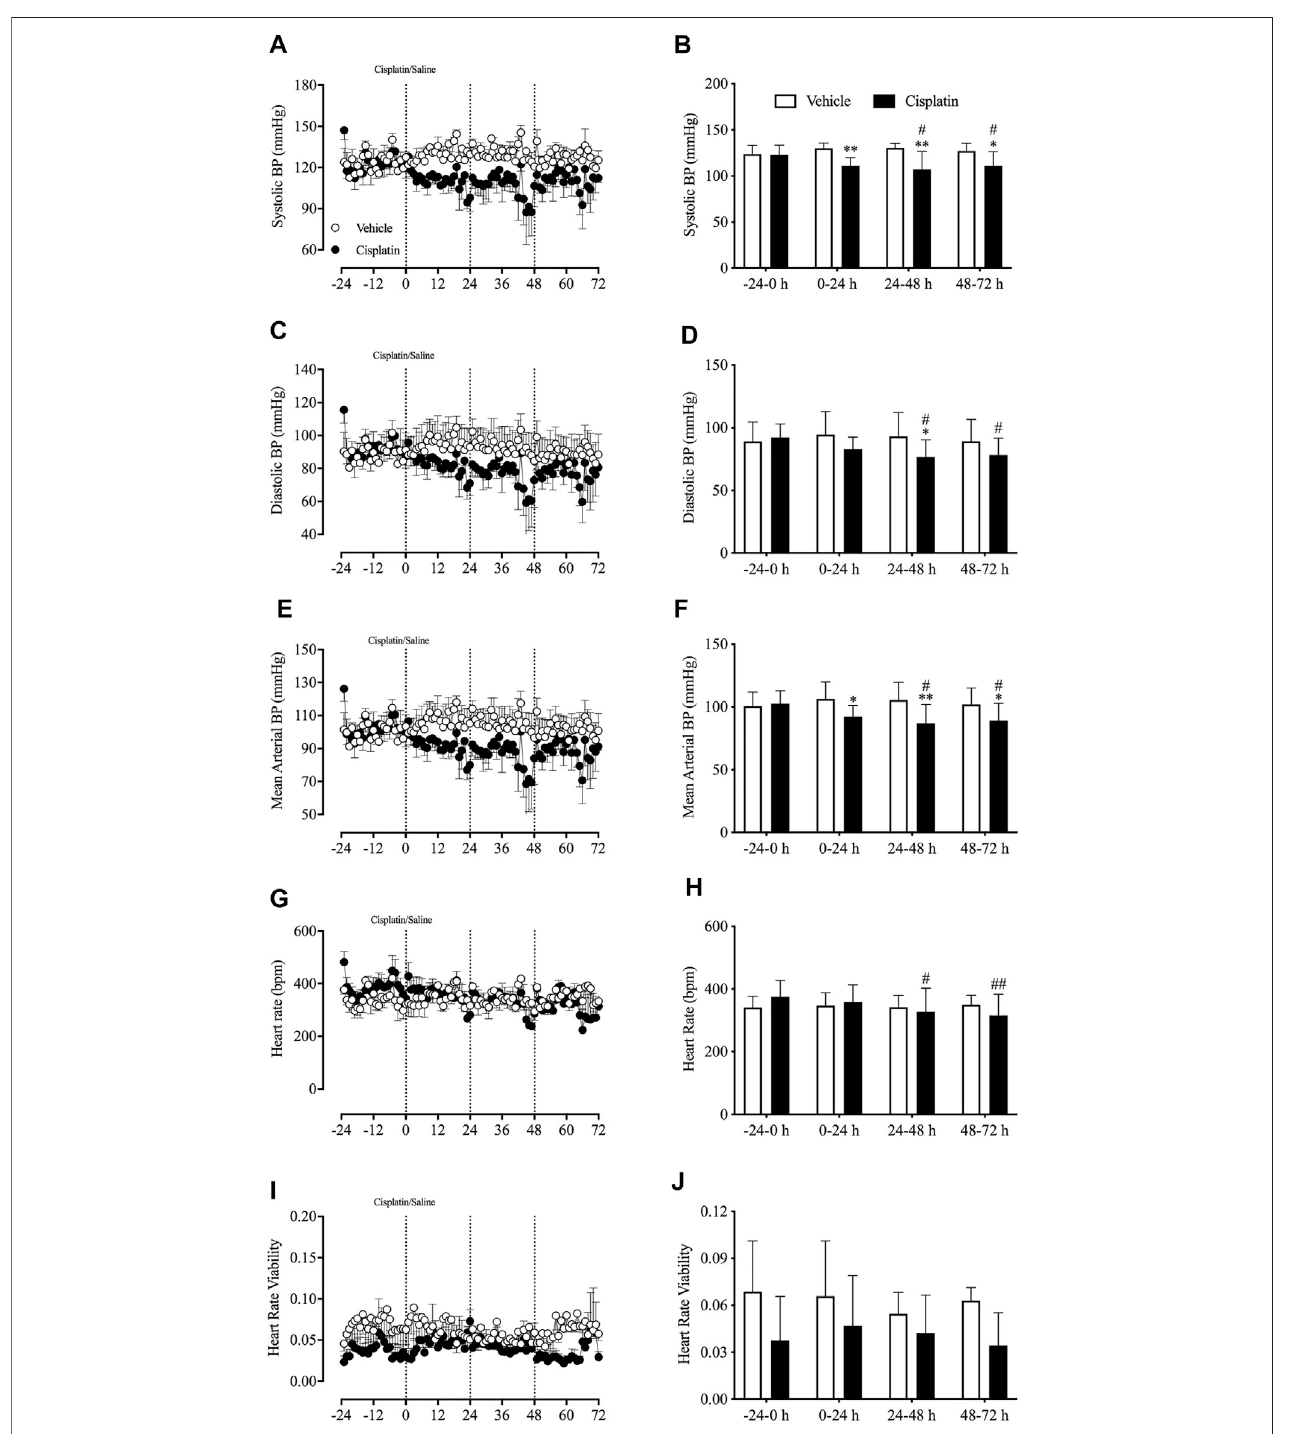
FIGURE5| Effectofcisplatin(30 mg/kg,intraperitoneal)oncardiovascularhomeostasisin Suncusmurinus . (A) Systolicbloodpressure(BP); (B) changeinsystolic BP averaged over 24 h; (C) diastolic BP; (D) change in diastolic BP averaged over 24 h; (E) mean arterial BP; (F) change in mean arterial BP averaged over 24 h; (G) heart rate (HR); (H) change in HRaveraged over 24 h; (I) heart rate viability (HRV); (J) change in HRV averaged over 24 h. Data are means ± standard errors of the mean for three animals. Signi fi cant differences relative to baseline ( − 24 – 0 h) of each group are shown as # p < 0.05 or ## p < 0.01 (two-way analysis of variance, followed by Bonferroni tests). Signi fi cant difference between the two groups are shown as * p < 0.05 or ** p < 0.01 (two-way ANOVA followed by Bonferroni tests).